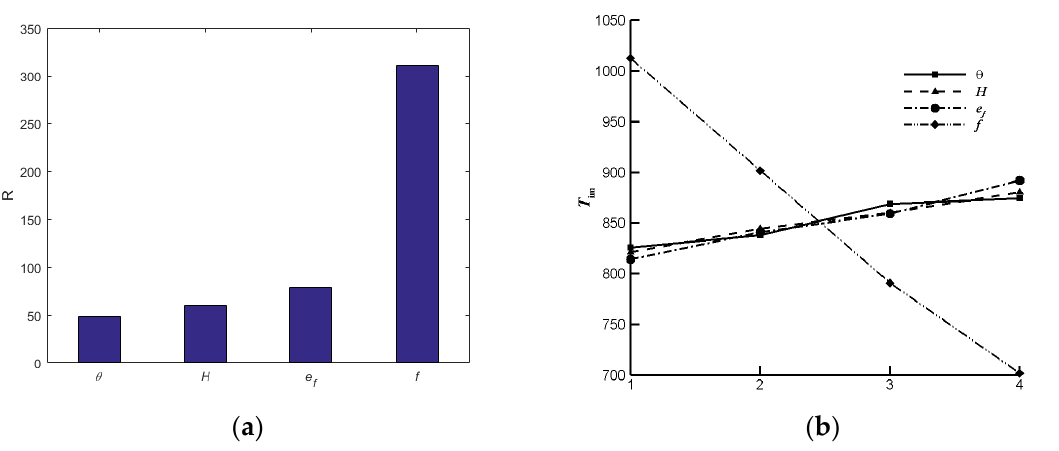
Figure 15. Range and influence trend of different parameters on T m . ( a ) Range. ( b ) Influence trend.